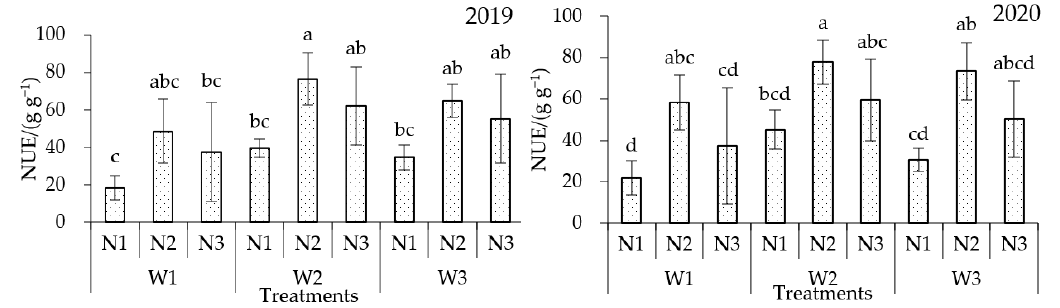
Figure 4. The nitrogen use efficiency of the green peppers in 2019 and 2020. Bars stand for standard error of the mean difference. Different small letters above the bars indicate a significant difference for various water levels and N treatments at p < 0.05 according to an LSD test within same